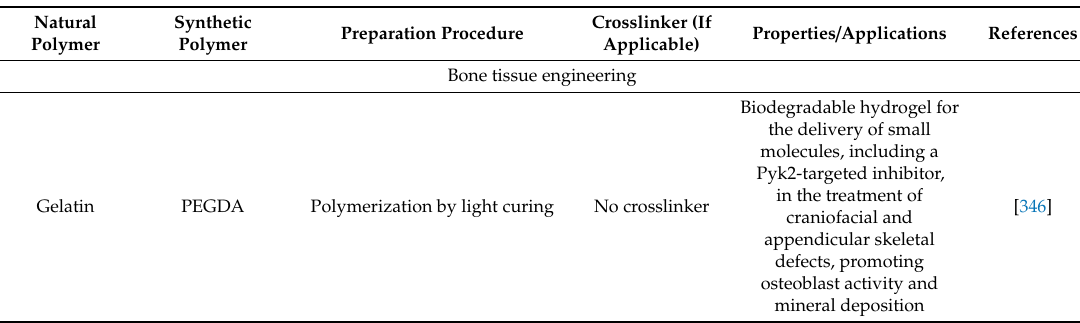
Table 4. Biomedical applications of protein based hybrid hydrogels in biomedical fields, preparation procedures, some properties and their